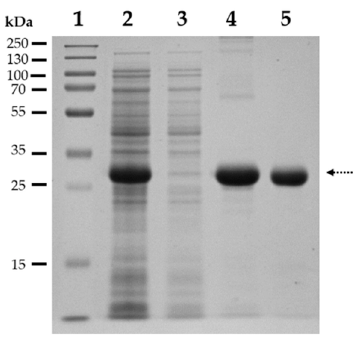
Figure 4 . Purification of SARS-CoV-2 3CLpro. Figure shows a Coomassie-stained gel image, after SDS-PAGE analysis of samples: 1) Molecular weight standard; 2) Soluble lysate; 3) Ni-NTA affinity chromatography, flowthrough; 4) Ni-NTA affinity chromatography, eluate fraction of His 6 -SARS-CoV-2 3CLpro; 5) ion-exchange affinity chromatography, eluate of untagged SARS-CoV-2 3CLpro. Dotted arrow shows SARS-CoV-2 3CLpro, which has a slightly lower molecular weight than the His 6 -tagged enzyme.